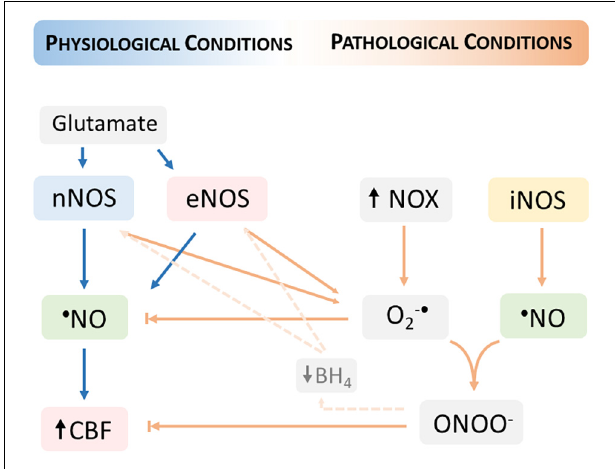
FIGURE 2 | Neurovascular coupling dysfunction in pathological conditions fostered by oxidative distress. The increase in the steady-state concentration of oxygen (O 2 −• ) produced by the activation of nicotinamide adenine dinucleotide phosphate (NADPH) oxidases (NOX) promotes a decrease in the • NO bioavailability and thus limiting the • NO- mediated cerebral blood flow (CBF) increase. The reaction of • NO with O 2 −• produces peroxynitrite (ONOO) − which additionally contributes to the dysfunction of neurovascular coupling, including by reducing the levels of tetrahydrobiopterin (BH4) and thus promoting the uncoupling of nitric oxide synthases (nNOS and eNOS). The uncoupled NOS produces O 2 −• contributing to increase its steady-state concentration. Under oxidative distress conditions, the inducible NOS (iNOS) supports a sustained • NO production that further reacts with O 2 −•